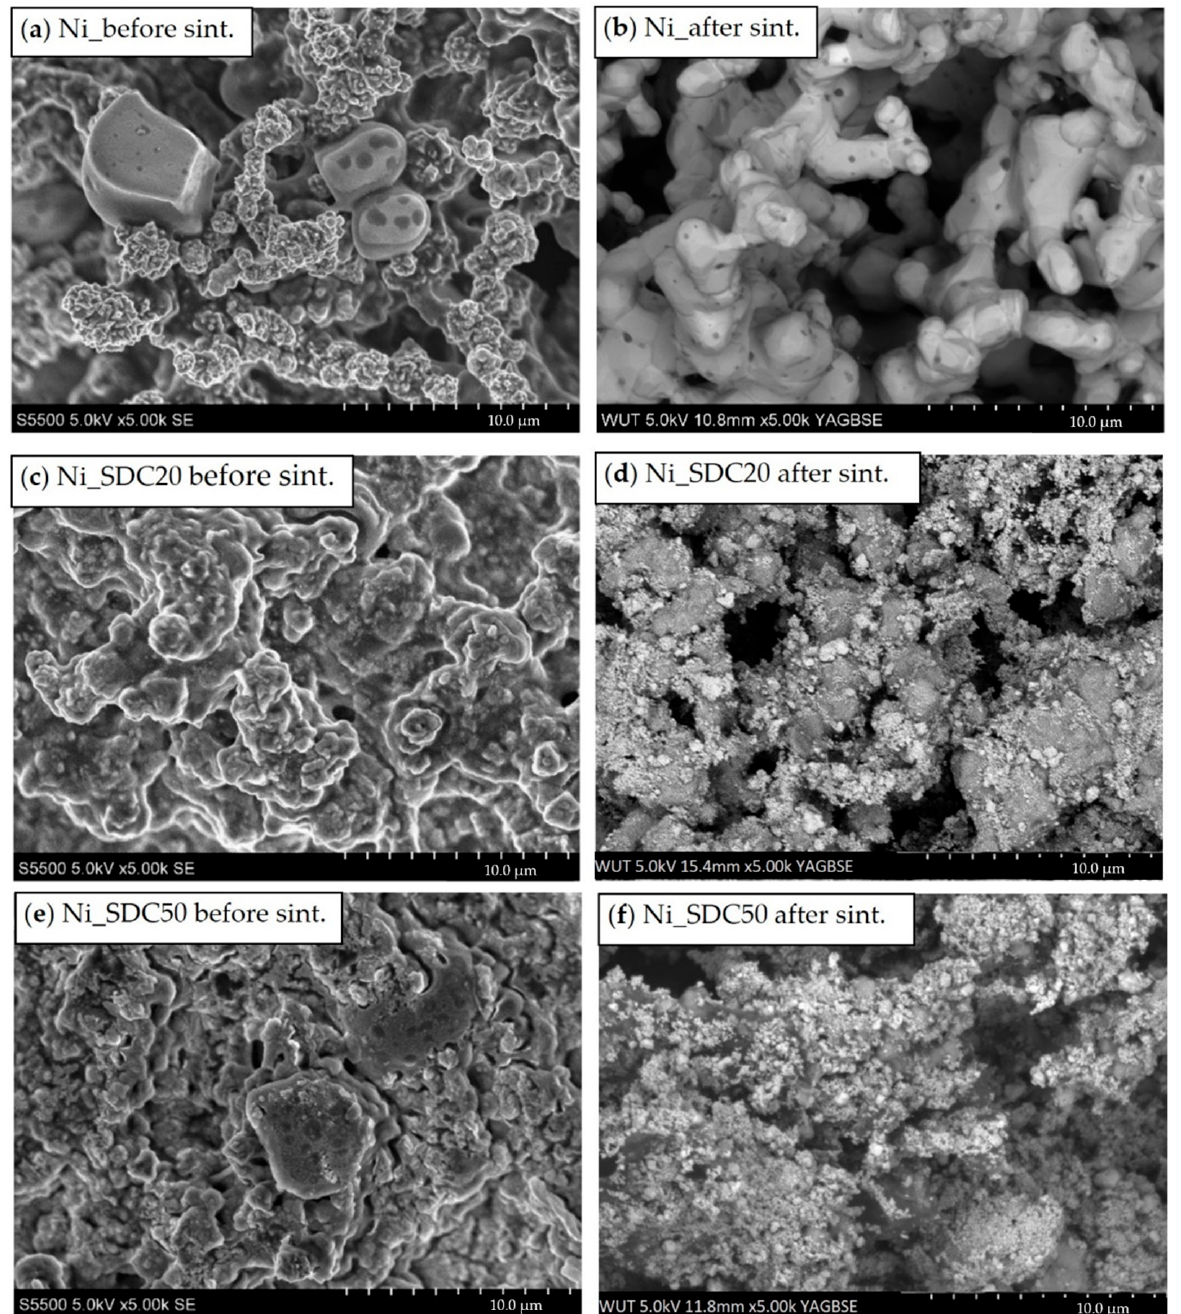
Figure 7. Selected SEM images of the cathode with different chemical compositions before and after sintering ( a , b ) cathode with nickel, ( c , d ) cathode with nickel and 20% SDC, and ( e , f ) cathode with nickel and 50% SDC.